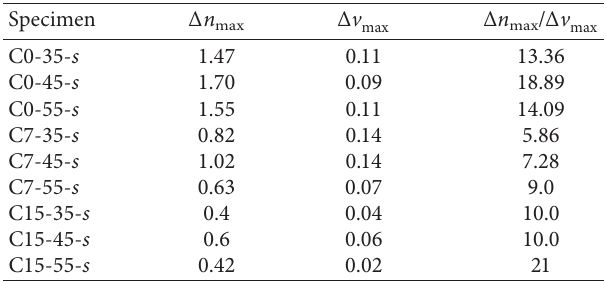
Figure 10: The change in trend of the relative nonlinear coefficient and relative ultrasonic velocity of specimens: (a) C0-35- s group; (b) C0- 45- s group; (c) C0-55- s group; (d) C7-35- s group; (e) C7-45- s group; (f) C7-55- s group; (g) C15-35- s group; (h) C15-45- s group; and (i) C15- 55- s group. Table 10: The analysis of the relative nonlinear coefficient and relative ultrasonic